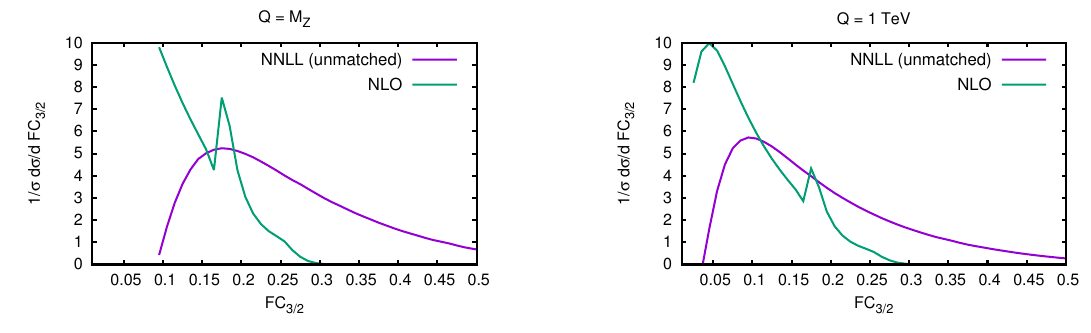
Figure 3 . Comparison between the unmatched NNLL distribution with central scales and the NLO prediction for the moment of EEC FC at Q = M Z (left) and Q = 1 TeV (right). 3 = 2